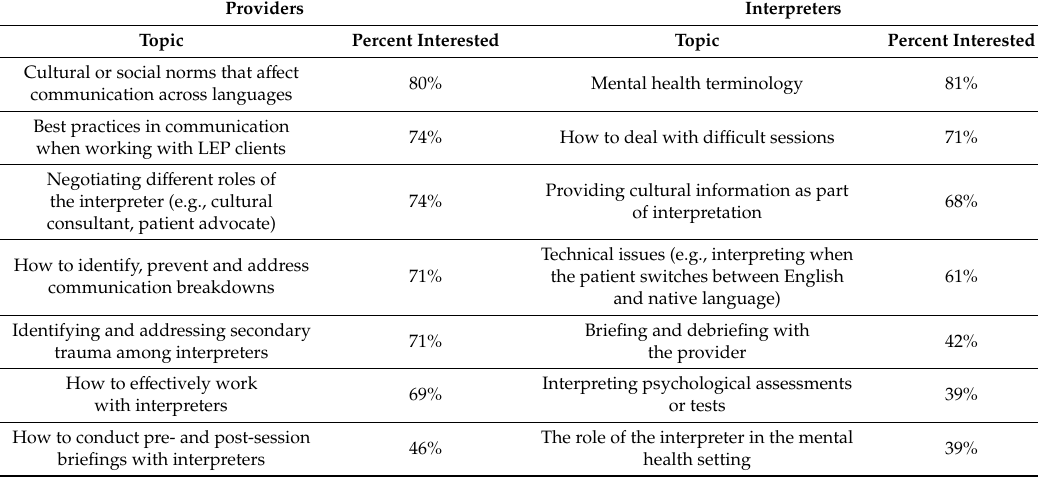
Table 1. Preferred Topics for Future